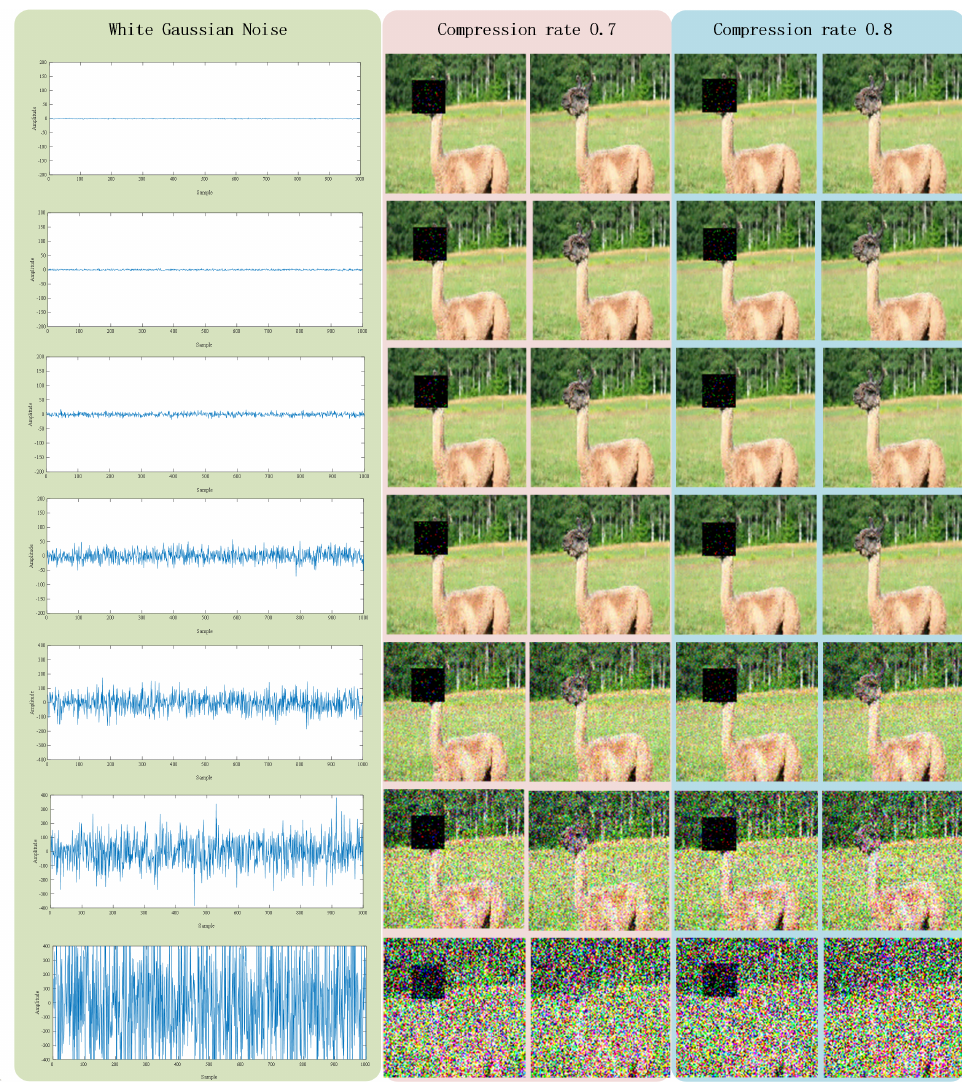
Figure 5. Reconstruction results with the impact of white Gaussian noise. The first column shows the noise with power values of 0, 5, 15, 25, 35, 40, and 50 in dBW, respectively. The second and third columns show the reconstruction results under compression rate 0.7, and the fourth and fifth columns show the reconstruction results under compression rate